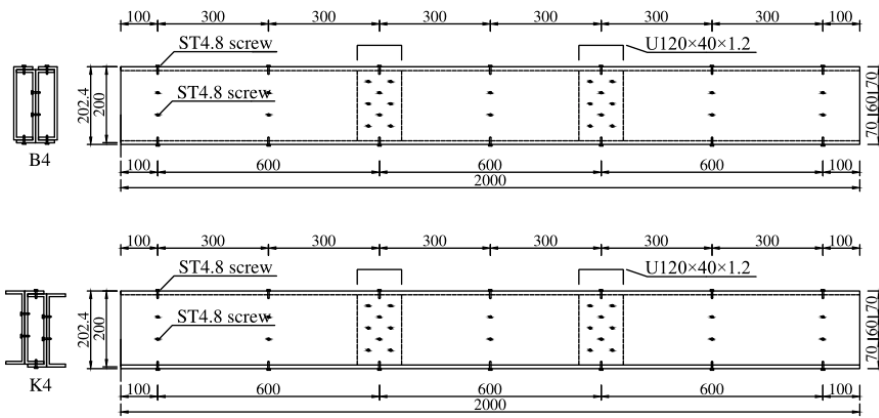
Figure 2. Dimensions of B4 and K4 beams (Unit: mm). Table 1. Nominal dimensions of beam specimens.